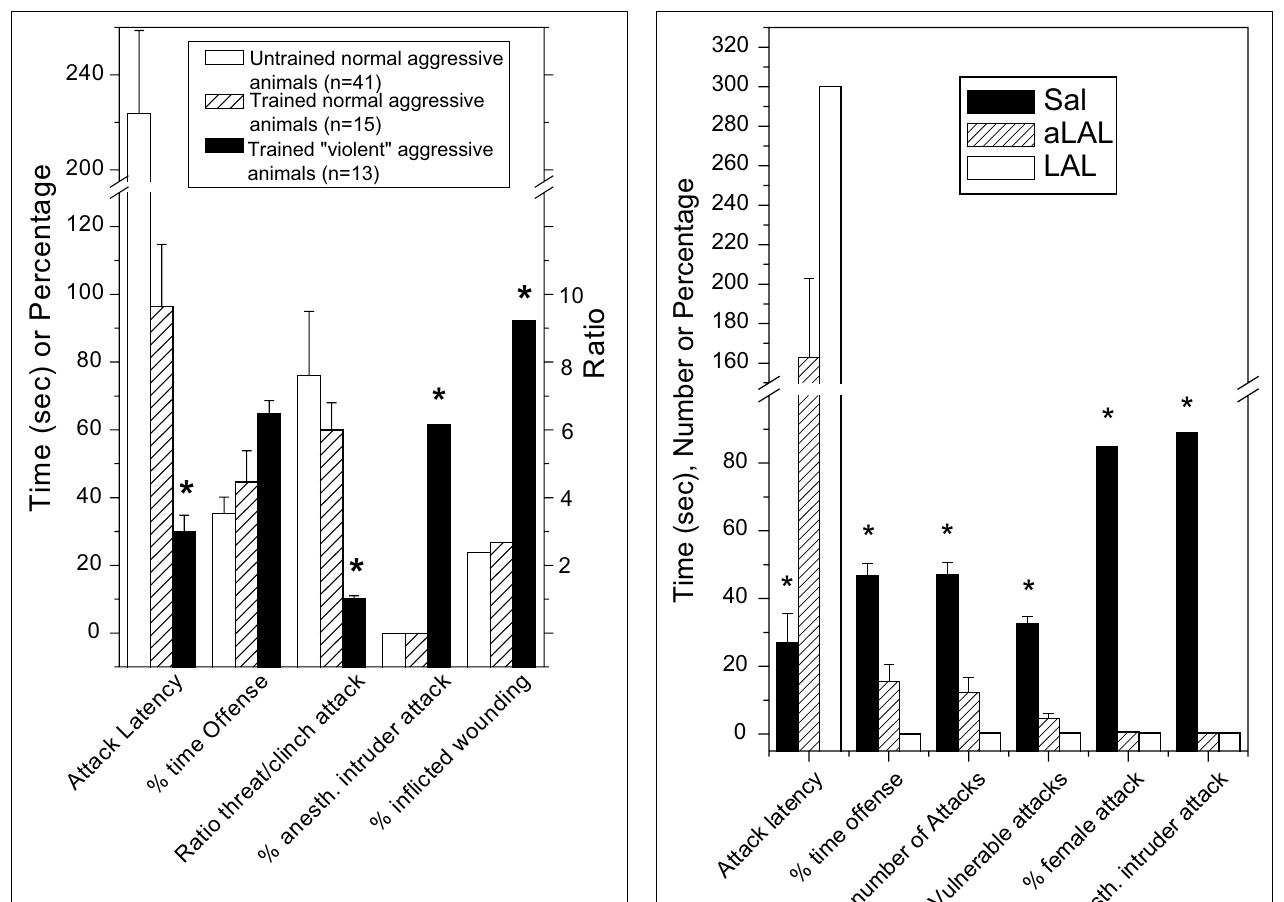
FIGURE 1 | Normal and ‘violent’ aggressive behavioral characteristics in resident wild-derived rats after none (naïve, untrained group) and repetitive (experienced, trained groups) victorious experiences. See de Boer and Koolhaas, 2005 for methodological details of the rat resident-intruder offensive aggression test. *indicates signifi cantly ( p < 0.05; student t -test) different from untrained and trained normal-aggressive